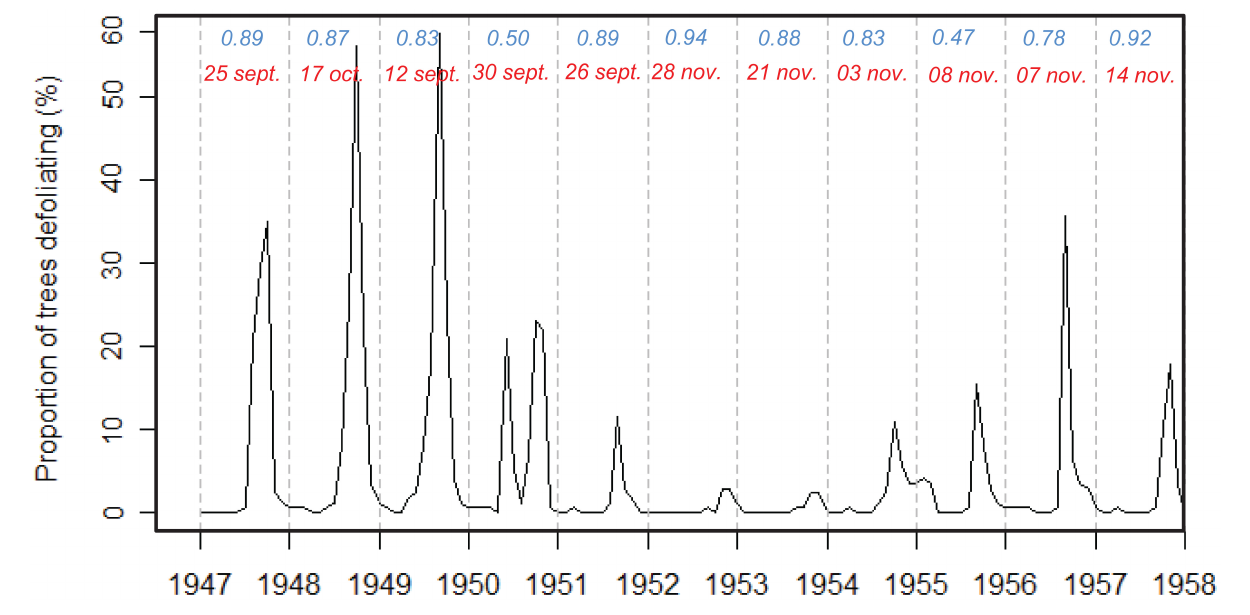
( Figure 2 ) and the leaf unfolding occurs before the start of the rainy season (July, August, and September) and